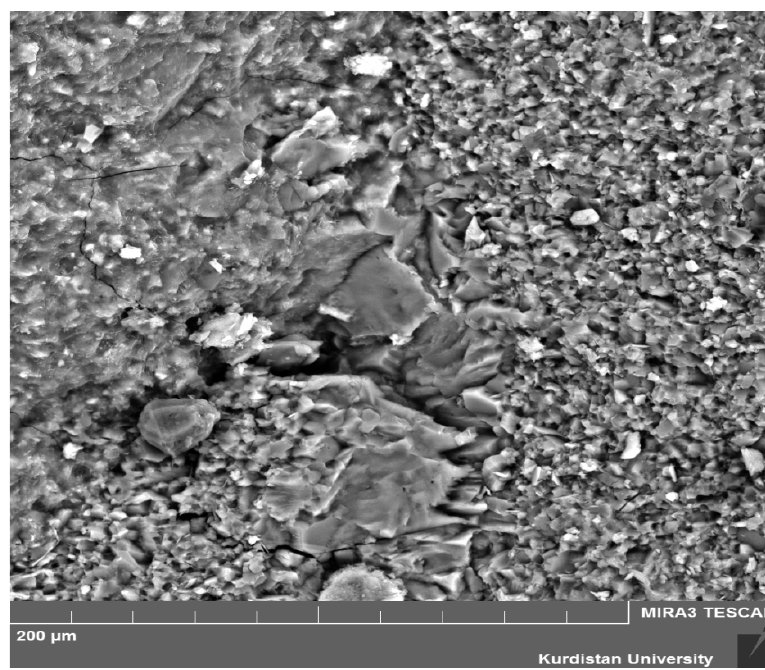
Figure 8. SEM of control sample at 28 days.